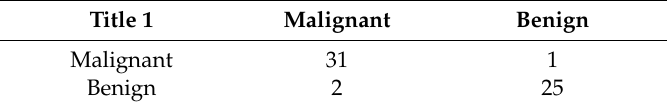
Table 8. Best confusion matrix for the proposed CNN.